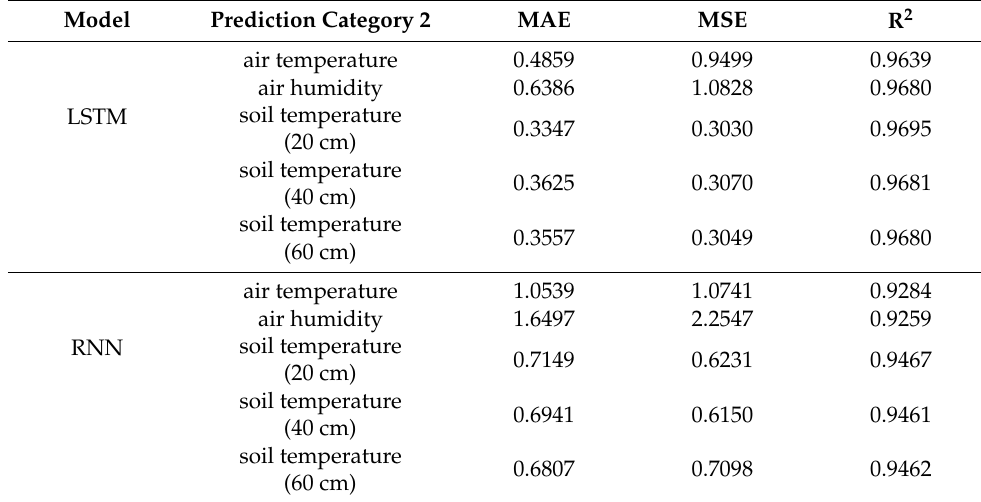
Table 8. Comparison of prediction performance between LSTM and RNN